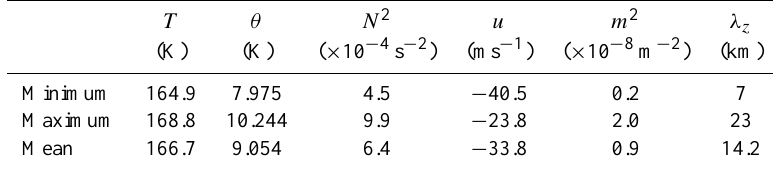
Table 1. Physical parameters observed within the duct of mesospheric front on 1 October